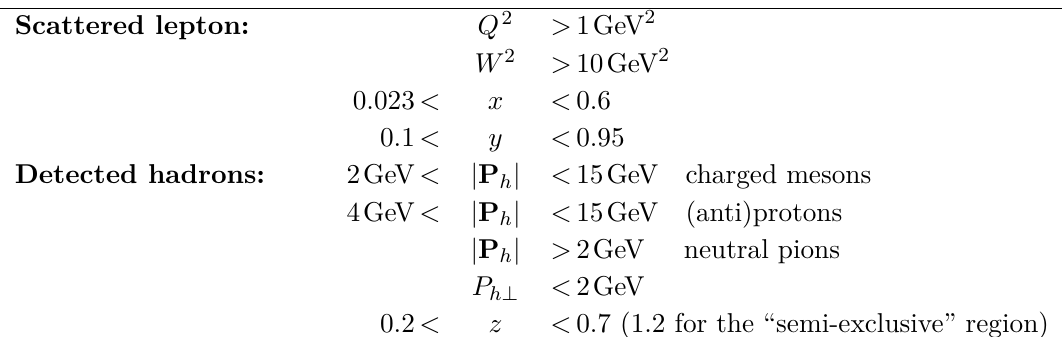
Figure 7 . Rapidity distributions for π + (left) and protons (right) in the kinematic region indicated. (Distributions are normalized to unity.)